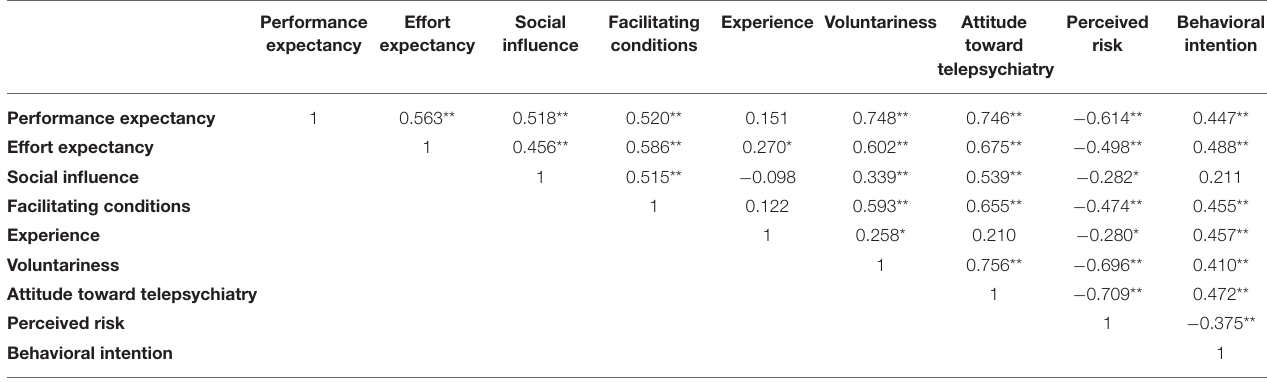
TABLE 7 | Pearson correlation between all study